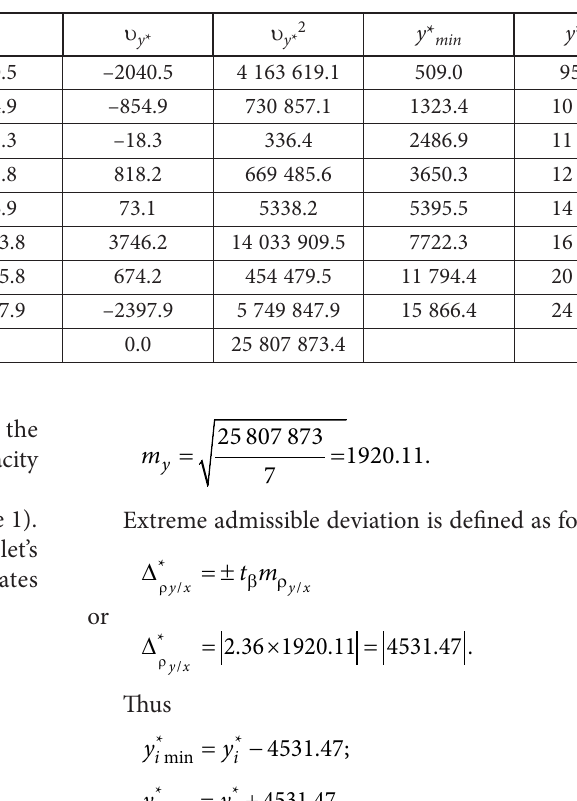
Table 4. Estimation of the linear approximation accuracy